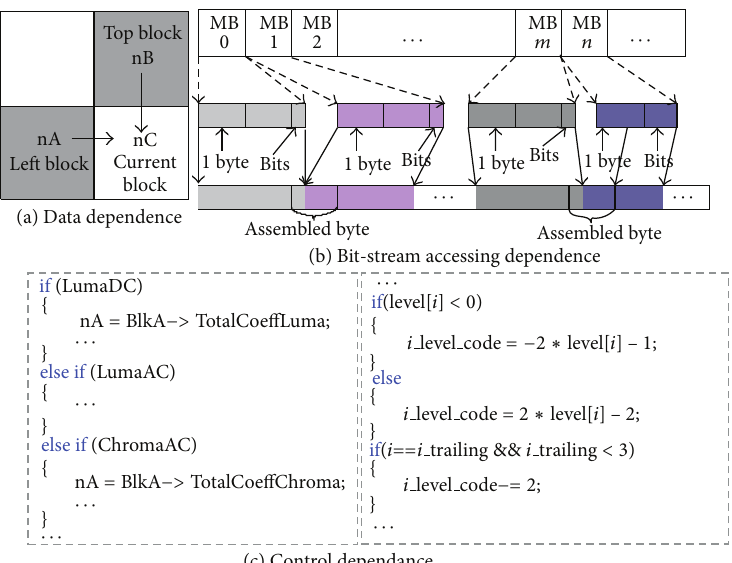
Figure 8: Dependence of the CAVLC encoder.